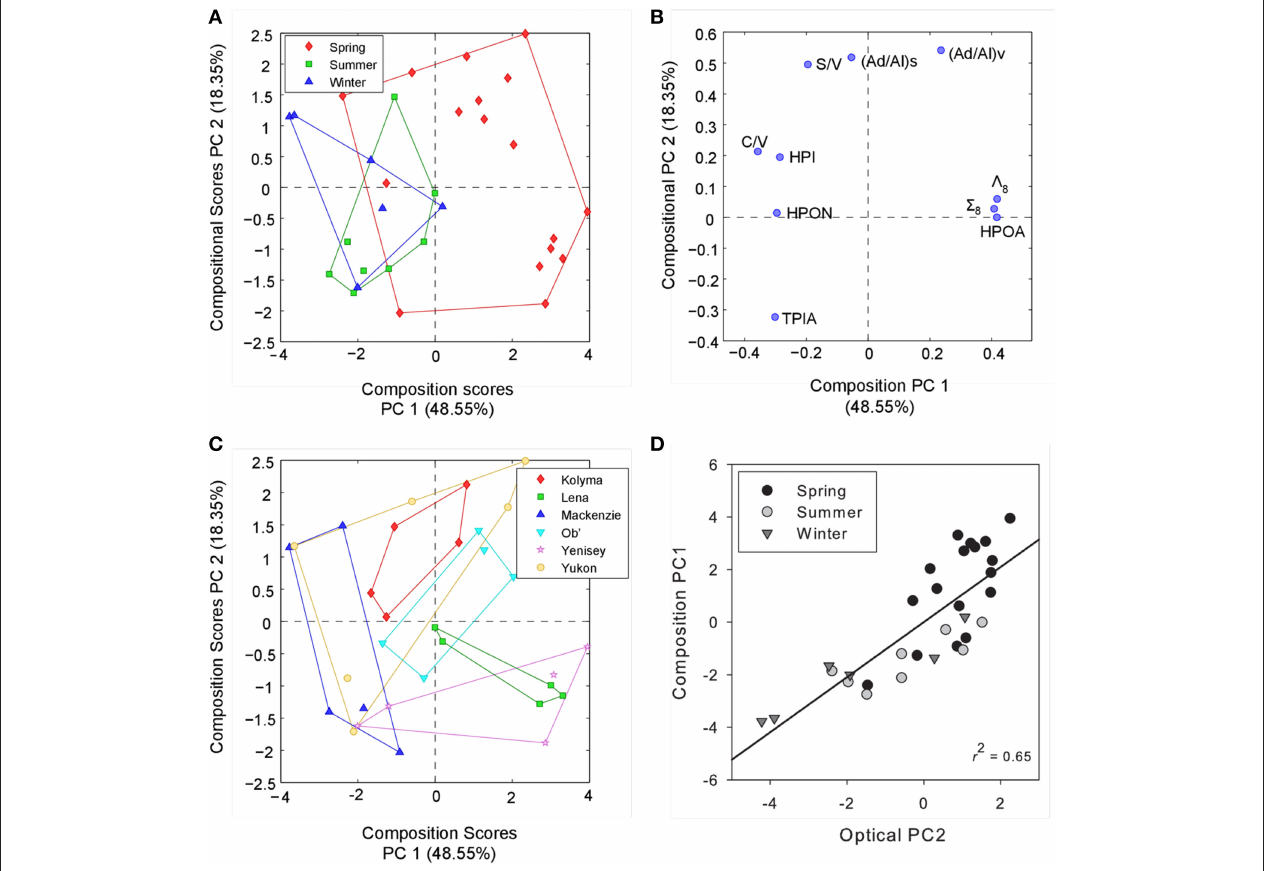
FIGURE 5 | (A) Principle component scores across PC1mol and PC2mol for all compositional measurements labeled by season. (B) PC scores of each compositional parameter across PC1mol and PC2mol. (C) Principle component scores across PC1mol and PC2mol for all compositional measurements labeled by river. (D) Relationship between PC2opt derived from optical data alone and PC1mol explaining compositional measurements. Black line represents the linear regression ( R 2 = 0.65, p < 0.001 ).